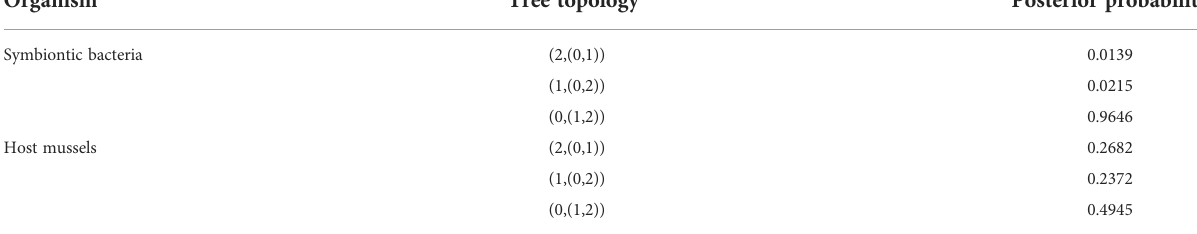
TABLE 4 Estimated phylogenetic topologies of host and symbiotic populations.